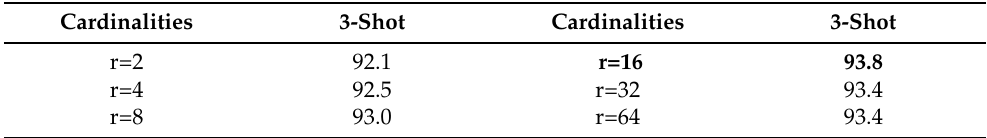
Table 3. The ablation experiments explored the impact of different r values (Section 4.4.2) on classification accuracy. Results of 5-way 3-shot setting on UCF101.